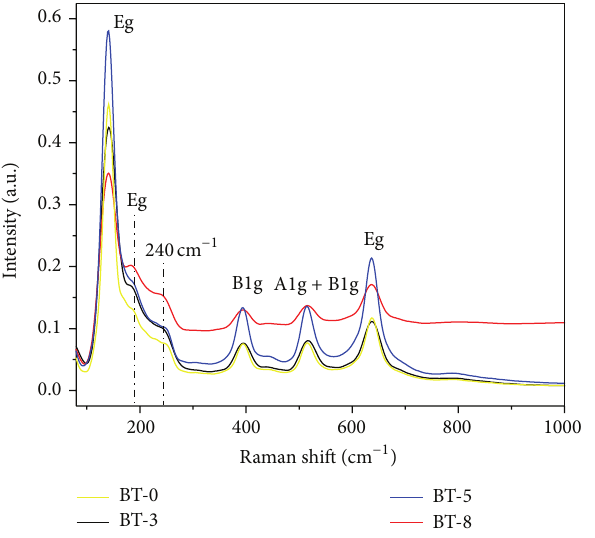
Figure 4: Raman spectra of boron doping samples.